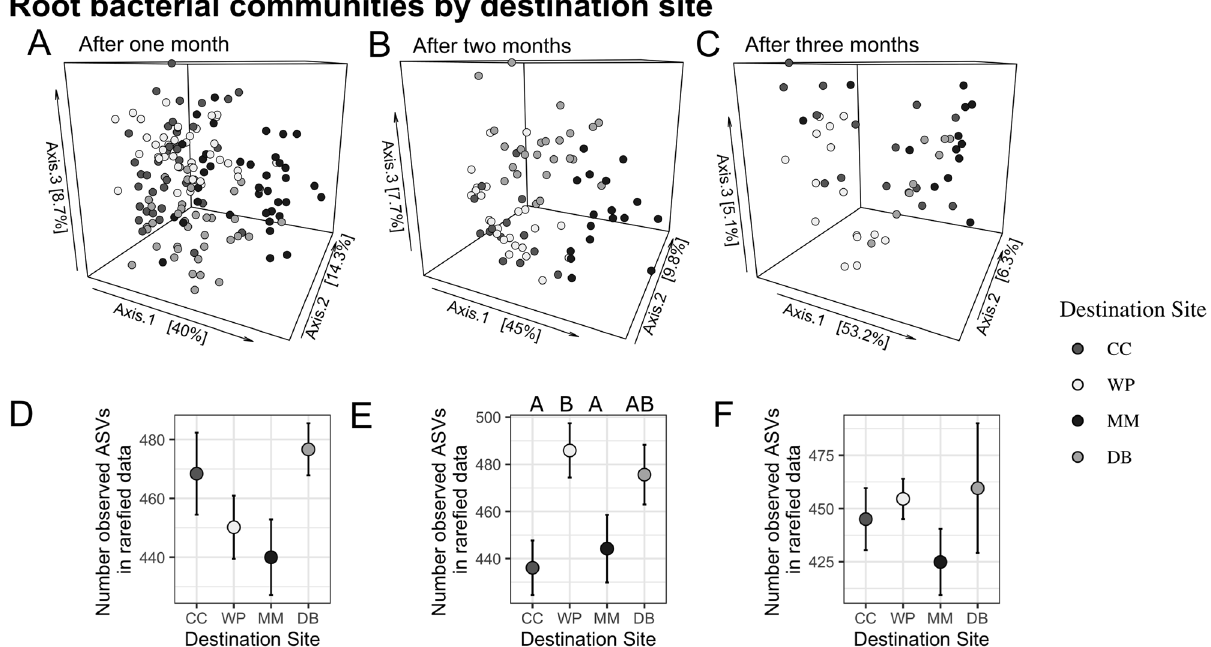
Figure 4. Differences in root microbial communities among destination sites. ( A – C ) 3-D ordination of root bacterial community structure based on principal coordinate analysis of phylogenetic-isometric log-ratio transformed distances. ( A ) shows differences among sites by destination site after one month, ( B ) after two months, and (C) after 3 months. All destination sites were distinct from others at all three timepoints (see Table 2). (D-F) Mean amplicon sequence variant (ASV) richness on roots at each site at 1, 2, and 3 months. Different letters above data points indicate significantly different ASV richness among destination sites.